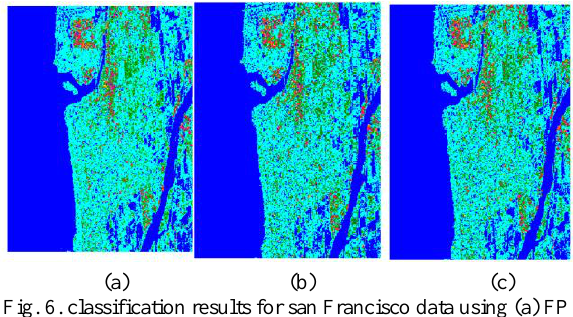
Fig. 6. classification results for san Francisco data using (a) FP method, (b) Zhang’s zones, (c) proposed zones. Table2. mean producer’s accuracies of the classifications based on the proposed and Zhang’s H - α